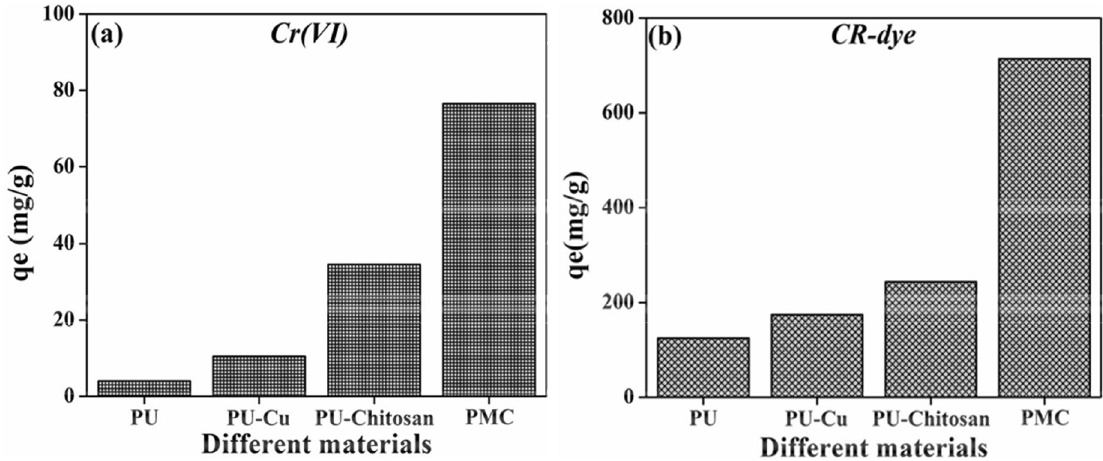
Figure 5. Different PU based composite materials for the adsorption of Cr(VI), and CR-dye.